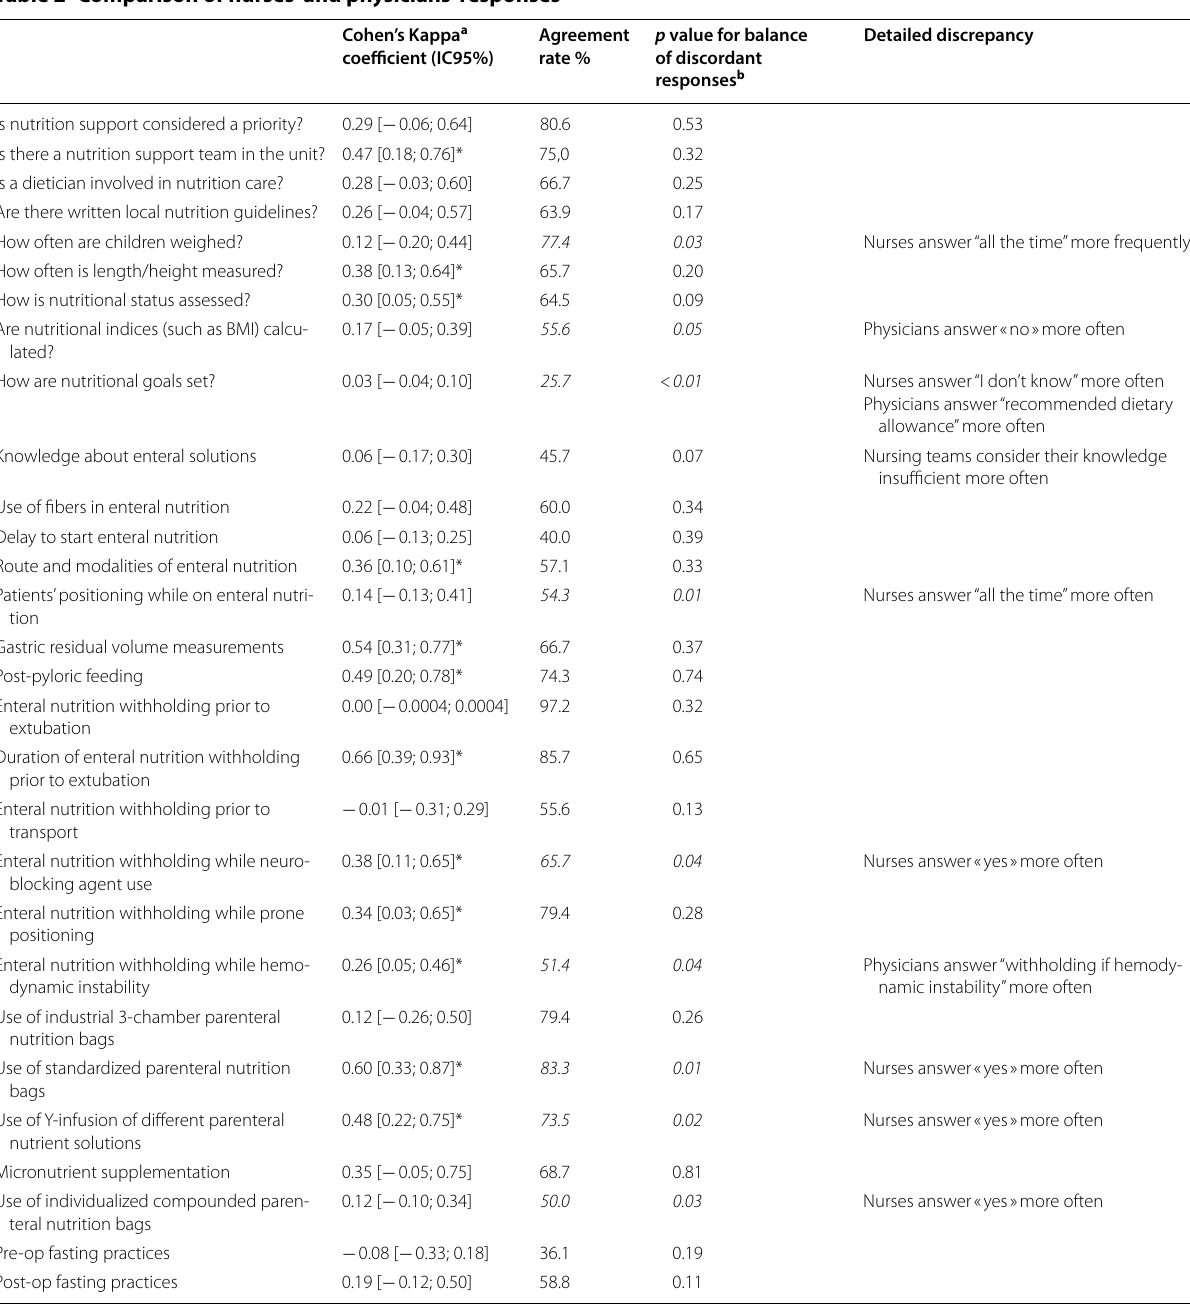
Table 2 Comparison of nurses’ and physicians’